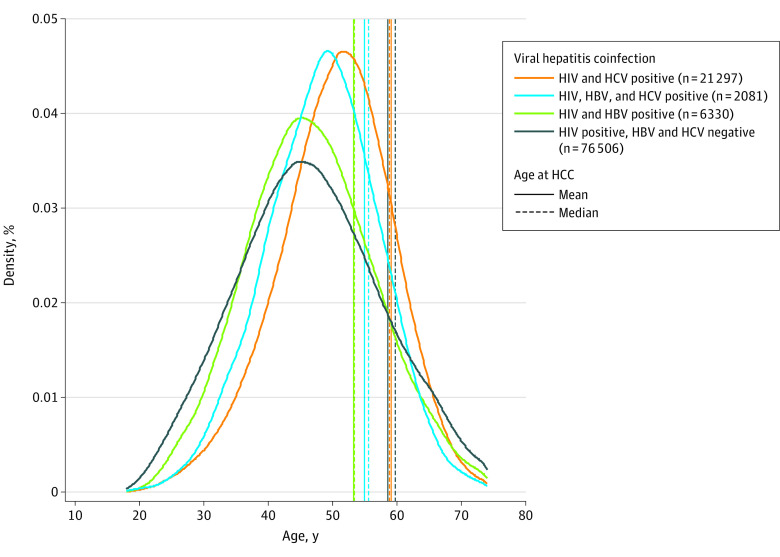
Age Distribution and Age of Hepatocellular Carcinoma (HCC) Onset by Viral Hepatitis Coinfection GroupsHepatitis B virus (HBV) infection was defined by detection of either hepatitis B surface antigen, hepatitis B e antigen, or HBV DNA in serum or plasma at any time during observation. Hepatitis C virus (HCV) infection was defined by the detection of HCV antibody seropositivity, HCV RNA, or detectable genotype in serum or plasma at any time under observation. Dashed vertical lines denote median age at HCC diagnosis in each group, and solid vertical lines denote mean age at HCC diagnosis.